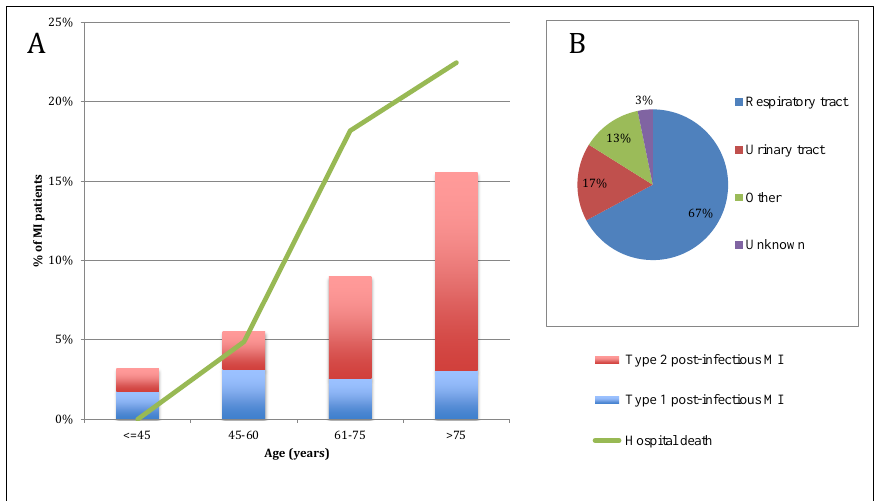
Figure 1. ( A ) Proportion of post-infectious myocardial infarction (MI) in patients hospitalized for MI in coronary care units, per age group and pathophysiological type of MI, and in patients dead in hospital. ( B ) Distribution of infection site in post-infectious MI. J. Clin. Med. 2019 , 8 , x FOR PEER REVIEW